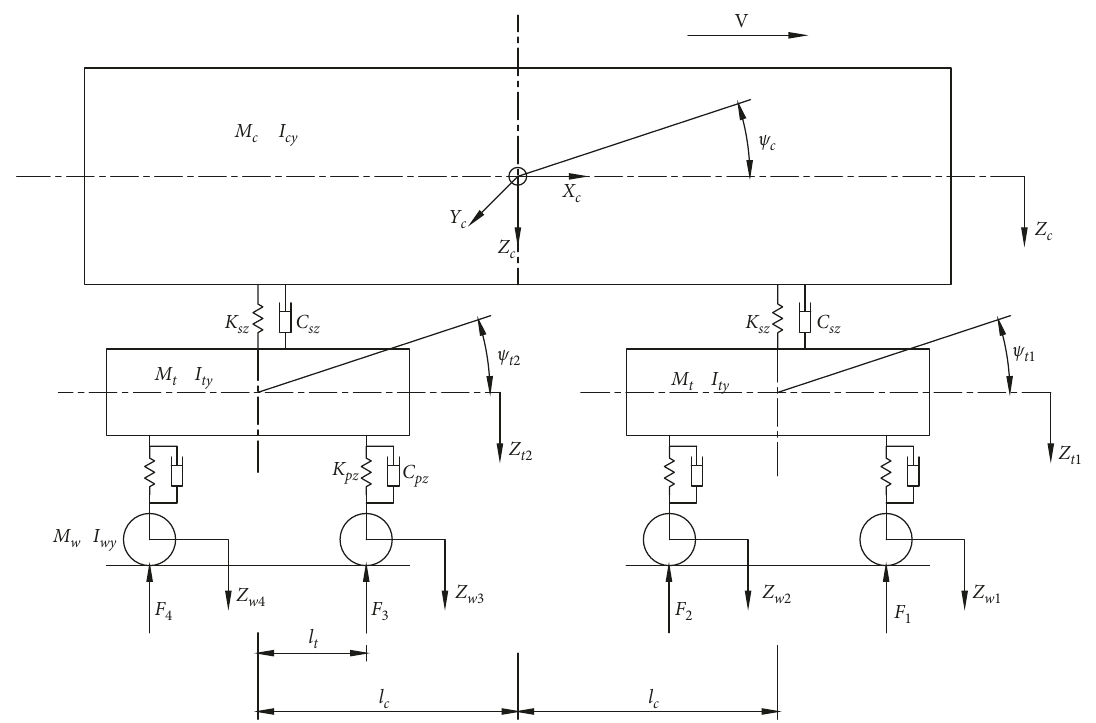
Figure 4: Railway vertical 10-degree-of-freedom dynamic model. Table 1: Degrees of freedom considered in the vertical 10-degree- of-freedom dynamic model of the